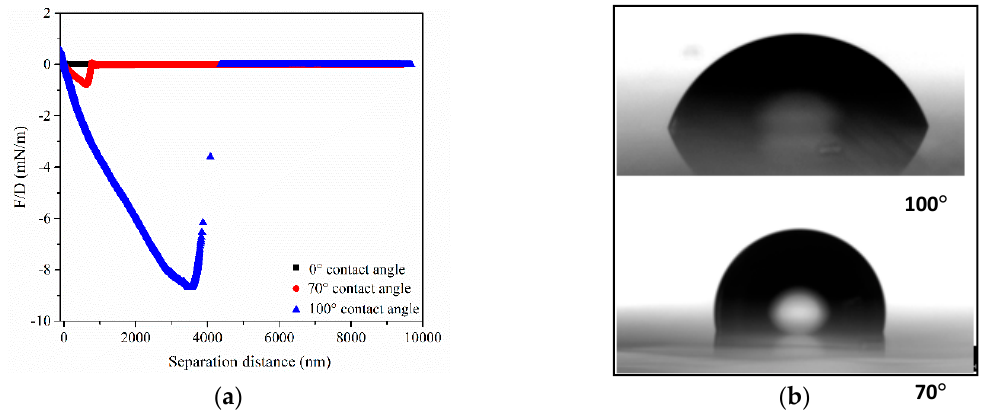
Figure 5. Effect of contact angle on the interaction force between glass microsphere and bubble with 1 μ m/s approach velocity ( a ). The right insets are the contact angle image ( b ).